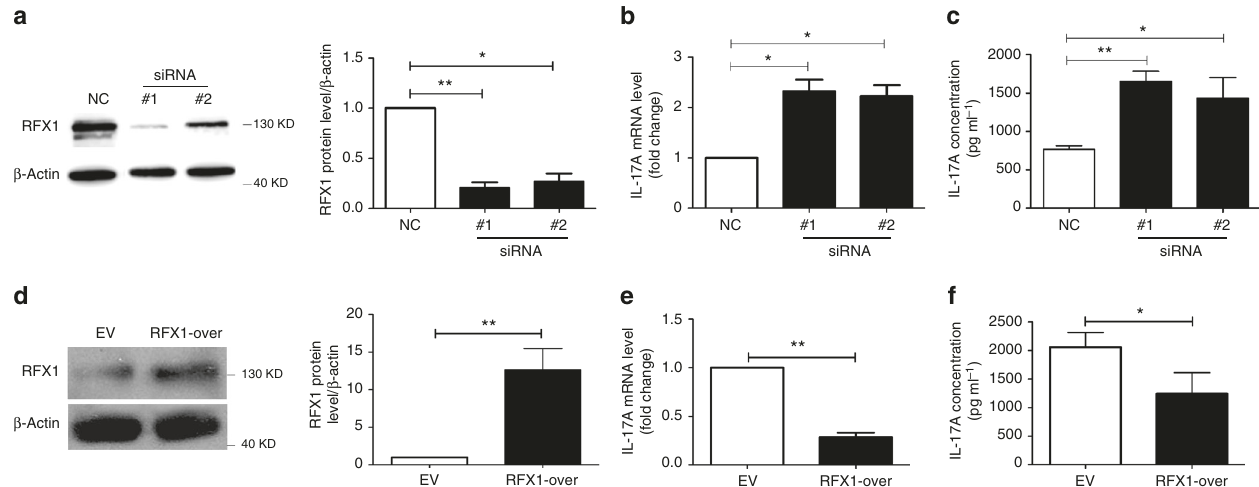
Fig. 2 RFX1 inhibits IL-17A expression in CD4 + T cells. a CD4 + T cells from healthy controls were transfected with negative control siRNA (NC), RFX1- speci fi c siRNA#1 or siRNA#2, along with anti-CD3 and -CD28 antibody stimulation. The RFX1 protein level was downregulated signi fi cantly in CD4 + T cells transfected with siRNA#1 or siRNA#2 compared with NC. Representative results of western blot analysis are shown in the left panel, and the quanti fi cation of three independent experiments is shown in the right panel. b mRNA expression levels of IL-17A in cells from three groups were quanti fi ed by RT-qPCR. c IL-17 protein levels in the supernatants of culture media of three groups were measured by ELISA. d CD4 + T cells from SLE patients were transfected with RFX1 expression plasmid or empty control plasmid. Representative results of western blot analysis are shown in the left panel and the quanti fi cation of three independent experiments is shown in the right panel. e mRNA expression levels of IL-17A in cells of two groups were quanti fi ed by RT-qPCR. f IL-17A protein levels in supernatants of culture media of two groups were measured by ELISA. Data are representative of three independent experiments (mean ± s.d.; n = 3). * P < 0.05 and ** P < 0.01, compared between the indicated groups. P -values were determined using the two-tailed Student ’ s t